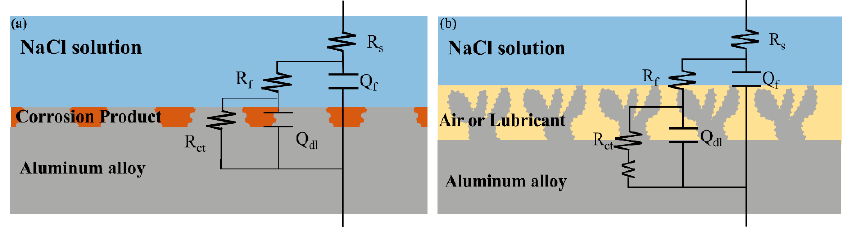
Figure 7. Equivalent circuits for analyzing EIS plots. ( a ) Untreated sample; ( b ) SHS and SLIPS.